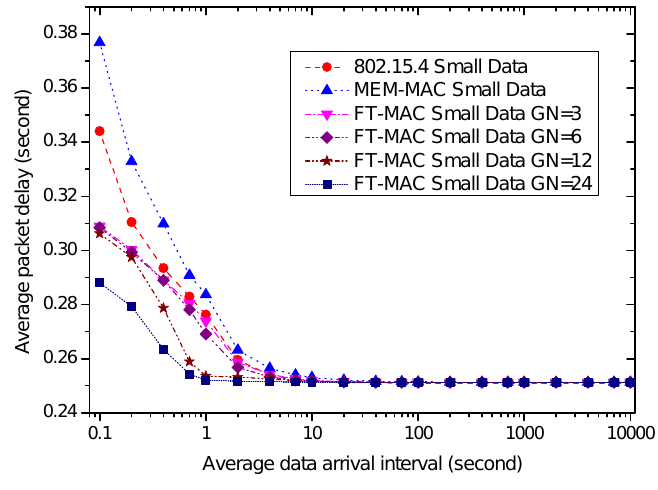
Figure 24. The effect of the average data arrival interval on average small data delay.